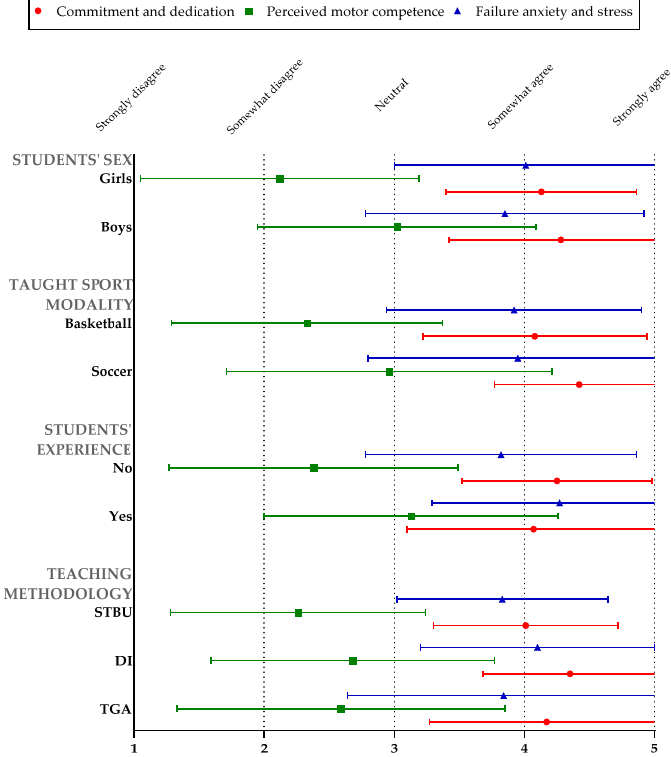
Figure 2. Descriptive results of the three dimensions according to the independent variables. Note: TGA = Tactical Games Approach methodology; DI = Direct Instruction methodology; STBU = Service Teacher ´ s Basketball